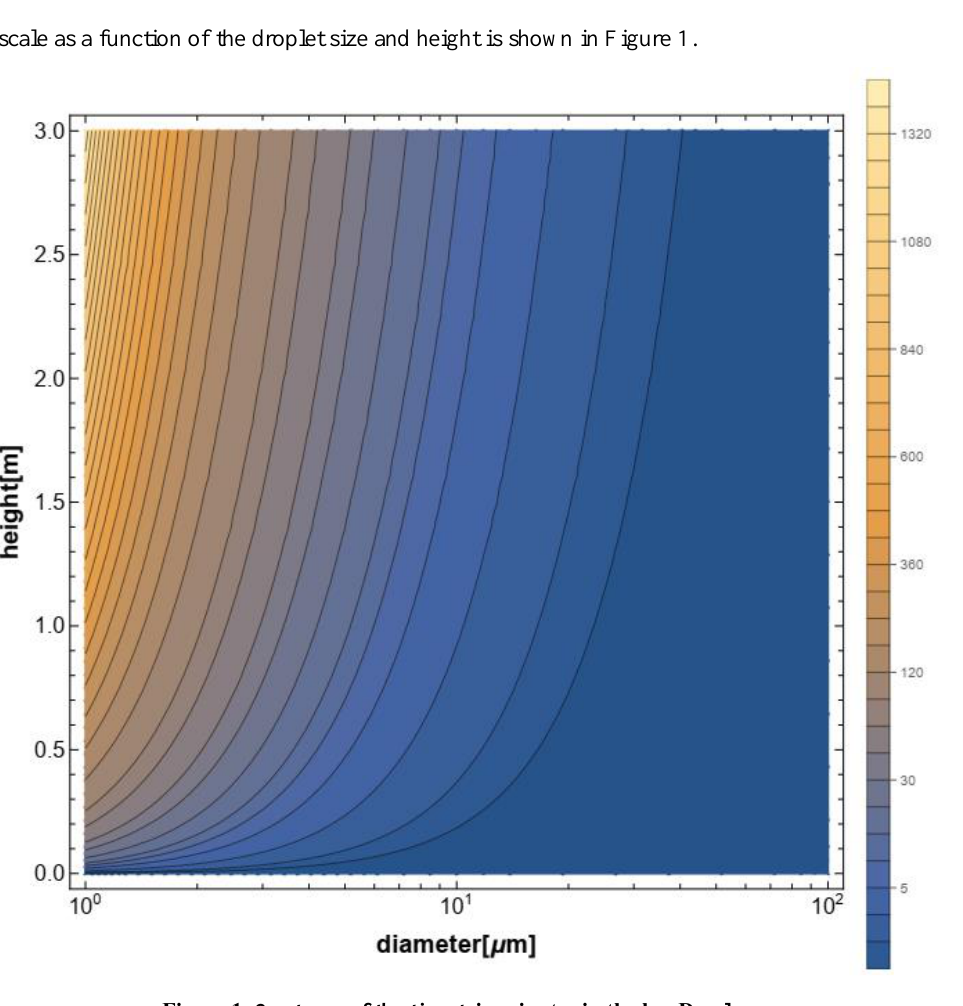
Figure 1. Contours of the time t f in minutes in the h − D V